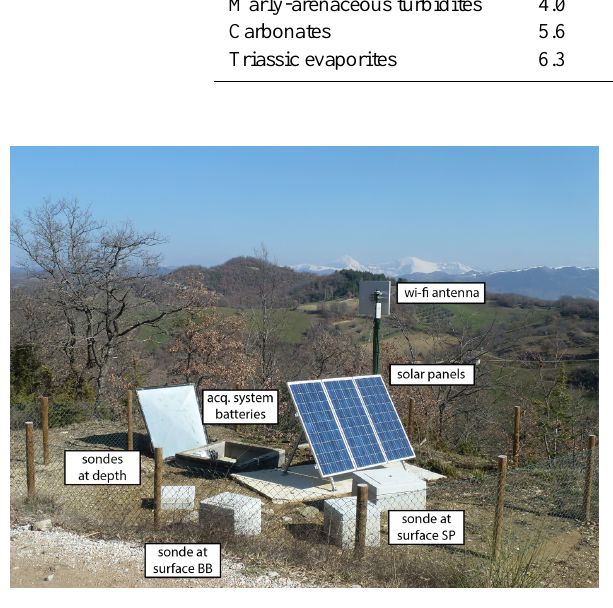
Figure 3. An example of a site hosting the seismic instruments: BAT2 station. The solar panels provide power to the acquisition and transmission system (Wi-Fi antenna). In the case of a lack of sun, there is a set of batteries that can power the station for about ten days. There are three concrete boxes accommodating the broadband (BB) and short-period sensors located at the surface plus the well- head with the cable connecting the seismometer at depth with the acquisition